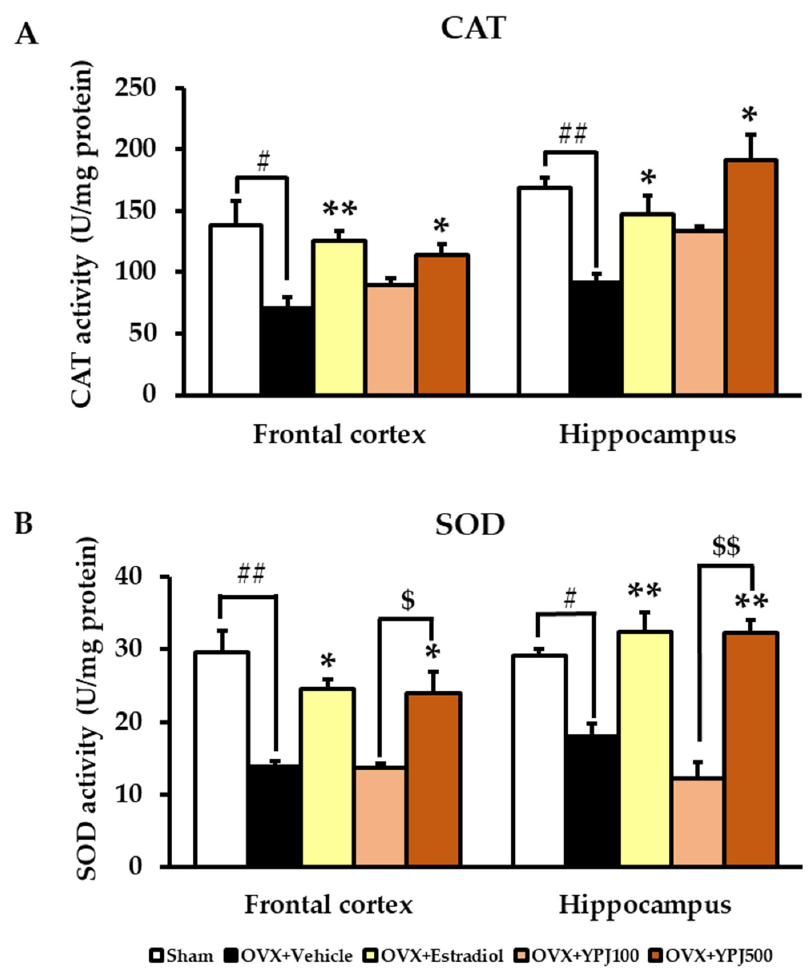
Figure 5. The effect of YPJ formula on antioxidant enzyme activities in the brains of OVX mice. A: catalase (CAT) activity, B: superoxide dismutase (SOD) activity. Data represent the mean ± SEM ( n = 5). Significant effects are represented by # p < 0.05, ## p < 0.001 vs. sham, * p < 0.05, ** p < 0.001 vs. OVX vehicle-treated mice, $ p < 0.05, $$ p < 0.001 between doses of YPJ (post hoc Tukey test).